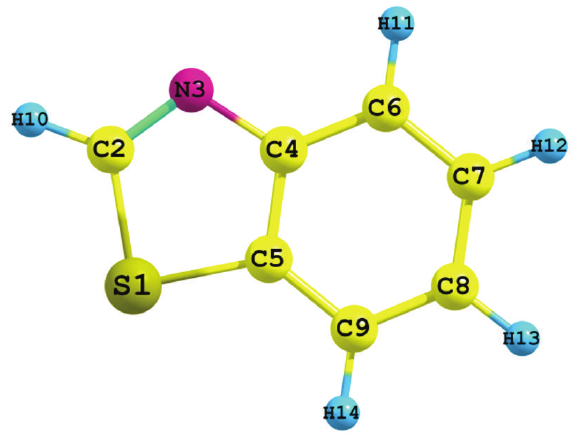
Figure 1: Optimized structure of